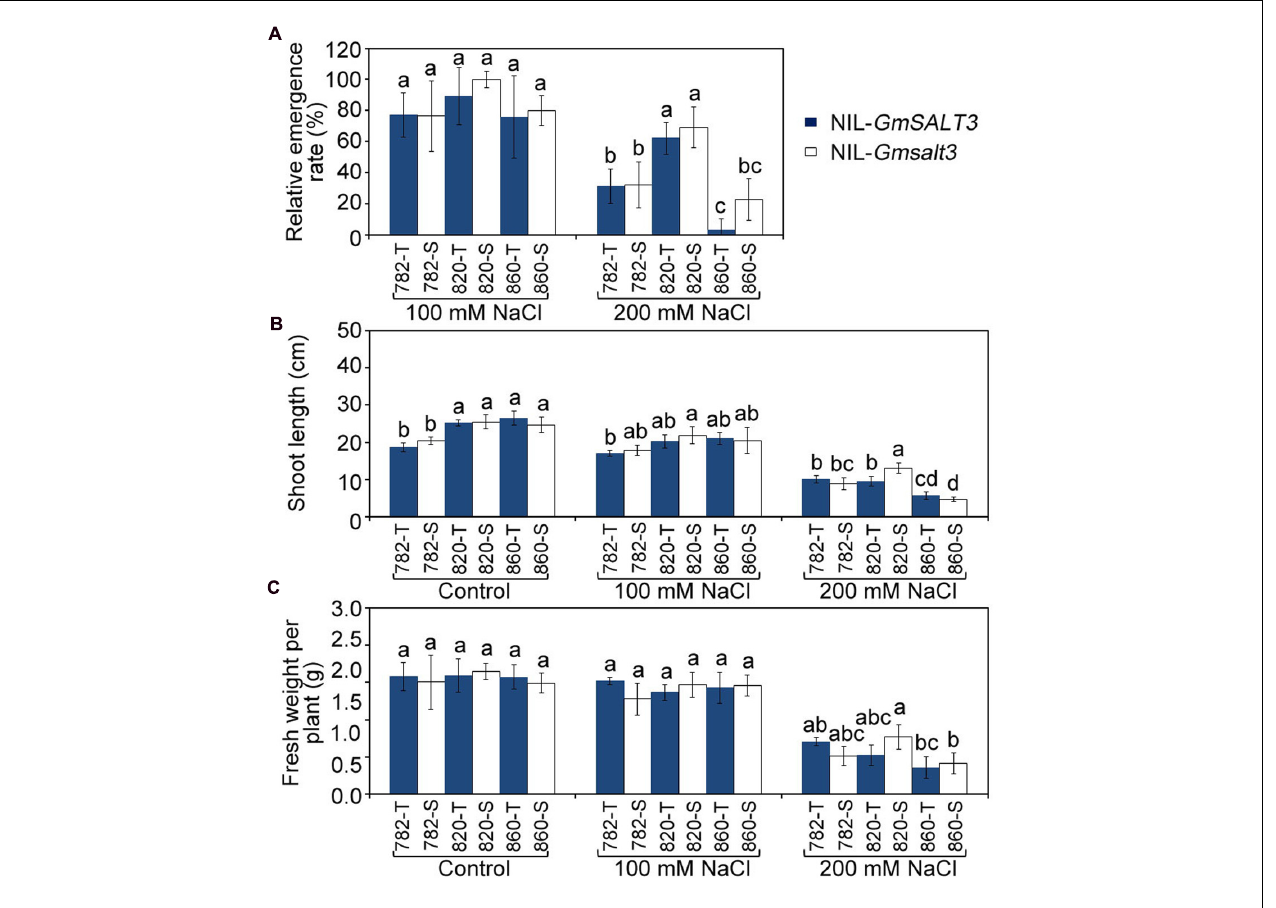
FIGURE 5 | Emergence rate after 10 days and early vigor after 15 days of three sets of NILs under control and NaCl stress conditions. (A) The relative emergence rate of three sets of NILs under NaCl stresses (EC = 10.6 dS m − 1 , 17.8 dS m − 1 ). (B) The seedling length of NIL lines under control and NaCl stress (EC = 10.6 dS m − 1 , 17.8 dS m − 1 ). (C) Average plant weight of three sets of NILs under control and NaCl stress (EC = 10.6 dS m − 1 , 17.8 dS m − 1 ). Data are means of three replicates ± SD ( n = 3). Different letters indicate statistically significant differences between NIL lines (one-way ANOVA followed by Tukey’s HSD post hoc test, P <